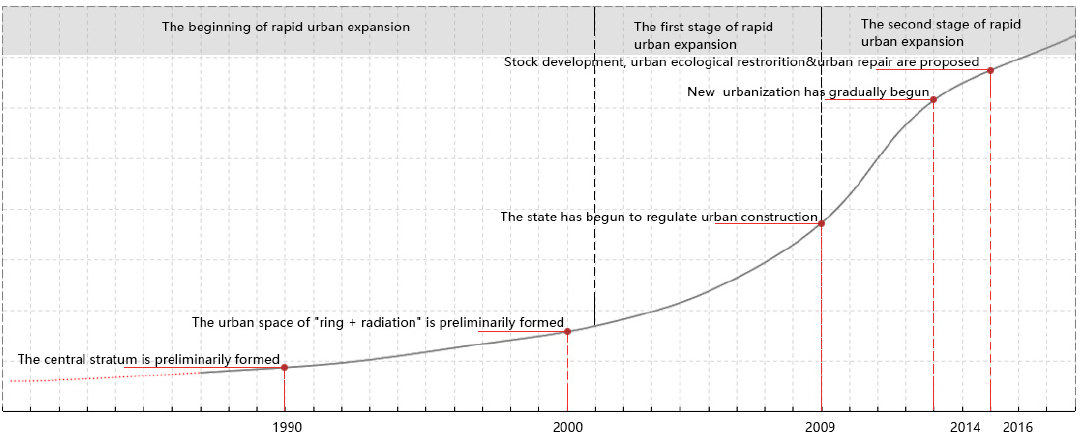
Figure 10. Changes in urban policy from 1987–2018.